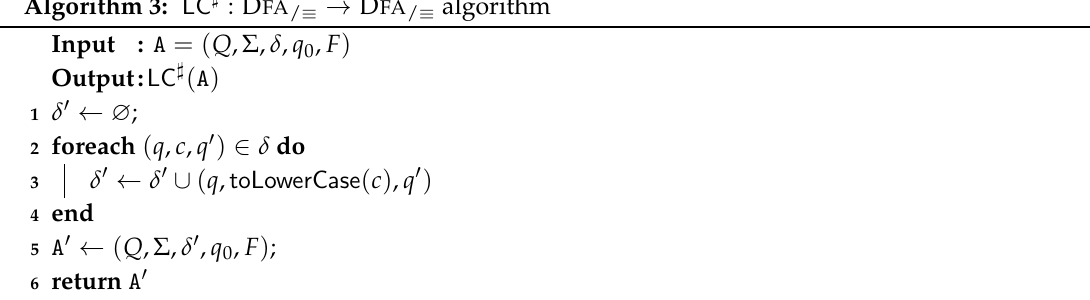
Algorithm 3: LC (cid:93) : D FA / ≡ → D FA / ≡ algorithm